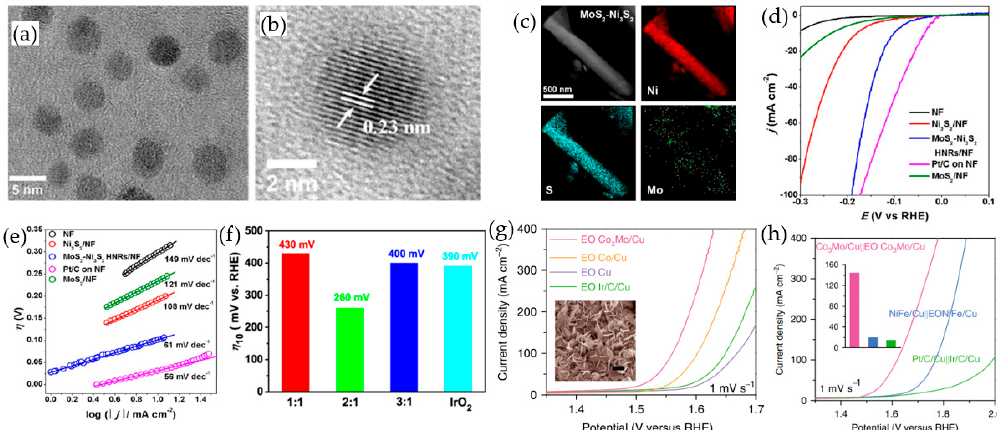
Figure 5. ( a , b ) HRTEM images of MSQCs [197]; ( c ) EDS and elemental mapping of MoS 2 -Ni 3 S 2 heteronanorods [203]; ( d ) polarization curves and ( e ) Tafel slopes of NF, Ni 3 S 2 /NF, MoS 2 -Ni 3 S 2 HNRs/NF, and Pt/C on NF and MoS 2 /NF [203]; ( f ) overpotentials of IrO 2 and Co/Mo carbides (Co 6 Mo 6 C 2 /NCRGO with different Co/Mo ratios 1:1, 2:1, 3:1) at 10 mA/cm 2 [204]; ( g ) polarization curves of EO Co 3 Mo/Cu, EO Co/Cu, EO Cu, and Ir/C/Cu (Inset: SEM image of EO Co 3 Mo/Cu) [208]; and ( h ) polarization curves for electrocatalytic water splitting of nanoporous Co 3 Mo/Cu and EO Co 3 Mo/Cu electrodes, nanoporous NiFe/Cu and EO NiFe/Cu electrodes and Pt/C/Cu and Ir/C/Cu, Inset: Comparison of current density at 1.65 V [208]. Reproduced from Refs. [197,203,204] with permission from copyright American Chemical Society and Ref. [208] with permission from copyright 2020 Springer Nature. Table 4. Onset potentials, overpotentials, Tafel slopes Mo-based OER catalysts.